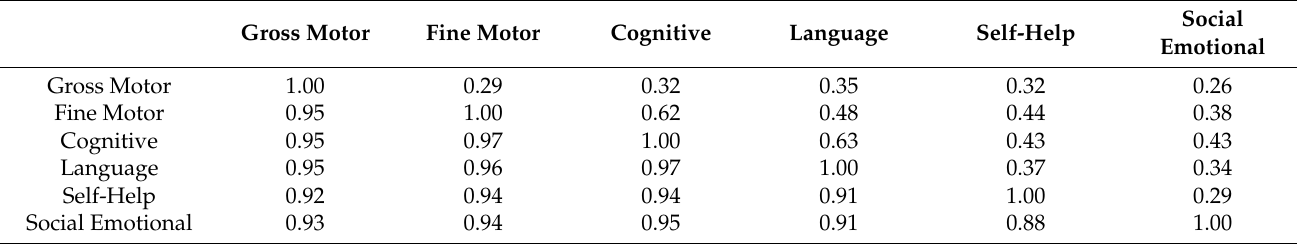
Table 6. Zero-order correlations and partial correlations controlled for age among the C-LAP’s six domains among participants from Shanghai between 2013 and